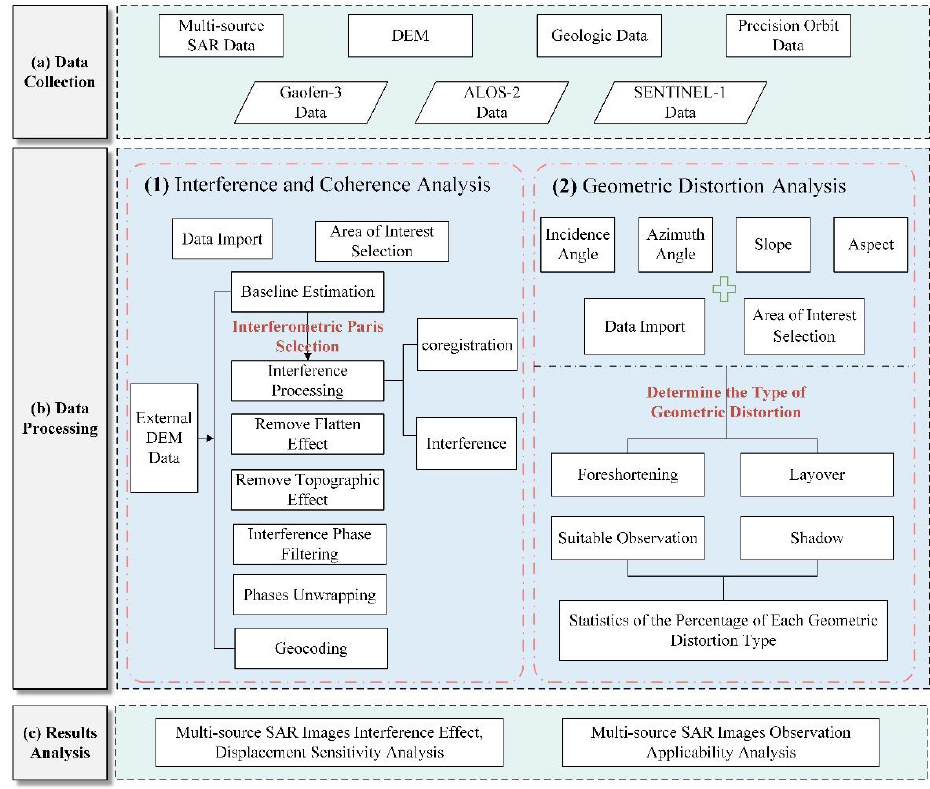
Figure 2. Flow chart for the interference effect analysis and observation applicability analysis.